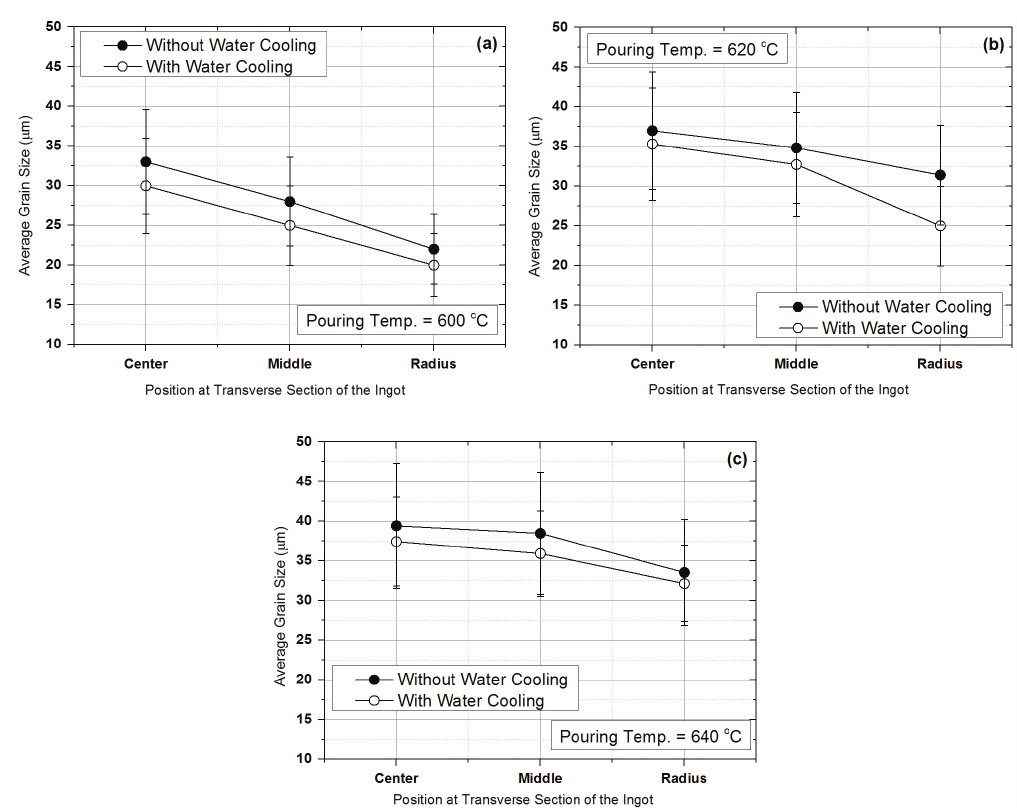
Figure 10. Variation of the grain size of primary α-Al grains with the position at the transverse section of the